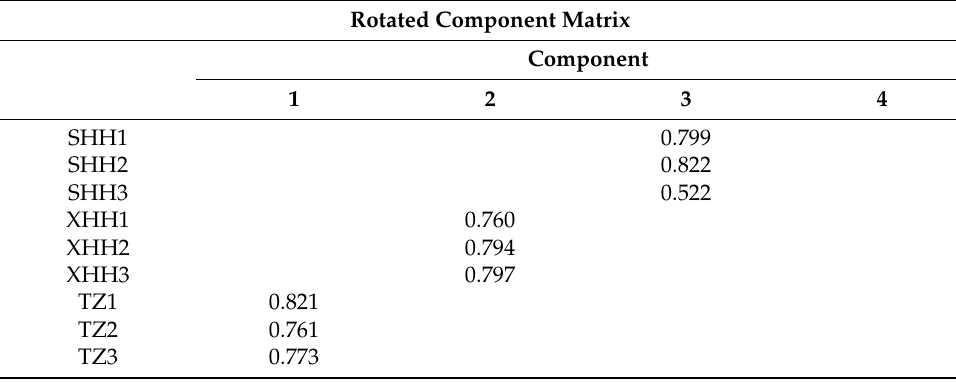
Table 5. Results of exploratory factor